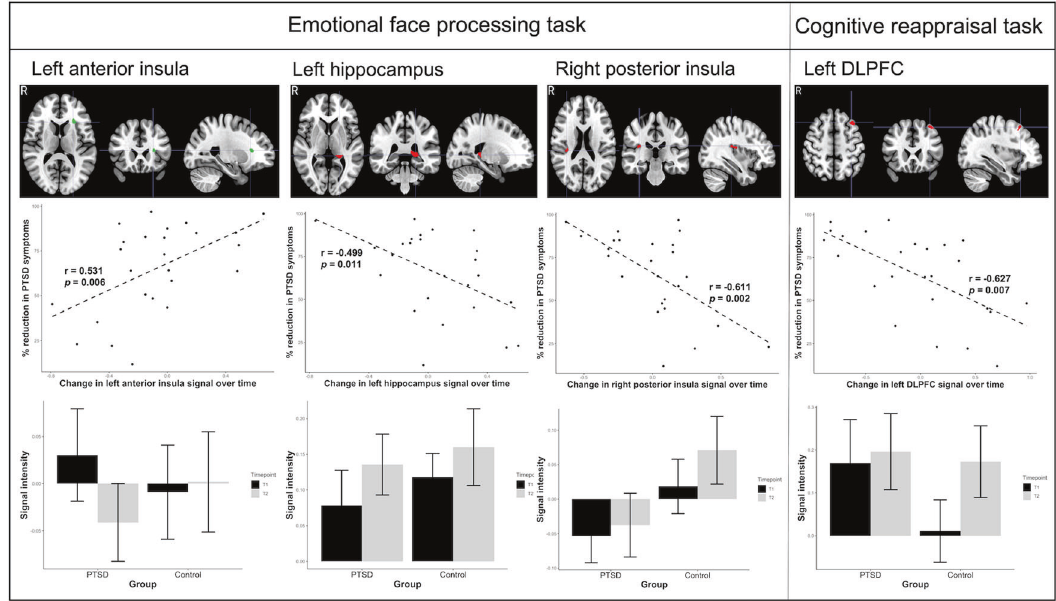
Fig. 2 Changes in fMRI activation during the emotional face processing task and cognitive reappraisal task. Columns depict brain regions in which the change in activation during the task from pre-treatment (T1) to post-treatment (T2) signi fi cantly correlated with changes in PTSD symptoms. Scatter plots on the second row depict change in signal intensity in the identi fi ed region and percentage reduction in PTSD symptoms. Bar plots in the third row depict mean activation in these regions at T1 and T2 for the PTSD and control